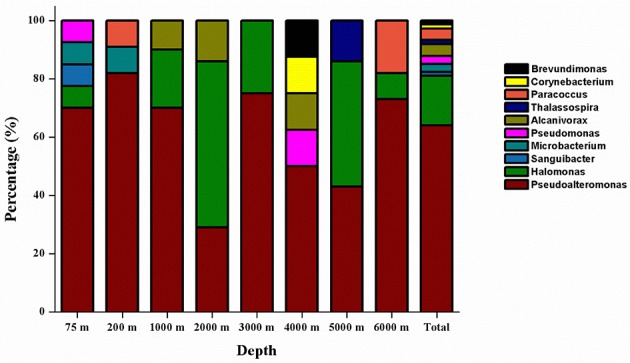
Relative percentage abundances of the phylotypic groups of cultivable bacteria recovered from seawater at eight different depths in the New Britain Trench.